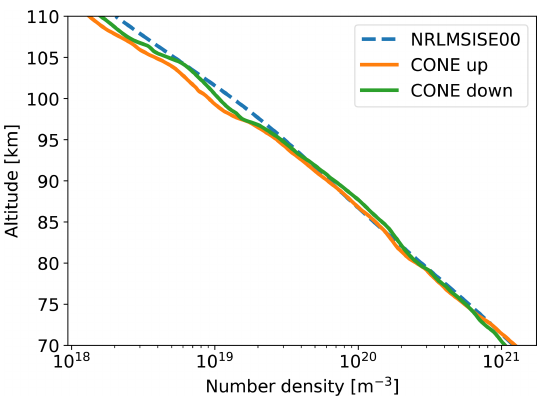
Figure 6. Rocket-borne density measurements by the ionization gauge CONE for the upleg and downleg (orange and green lines, respectively). The blue dashed line shows the NRL-MSISE00 cli- matology for the time of the WADIS-2 launch, i.e., 5 March 2015 at 01:44:00UTC.